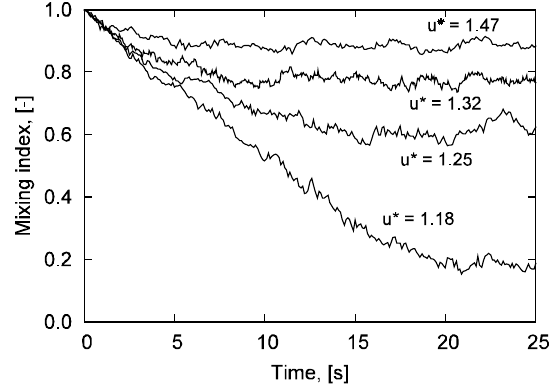
Fig. 3 Time evolution of the mixing index at the indicated gas dimen- sionless velocities. Simulation conditions are reported in Table 2